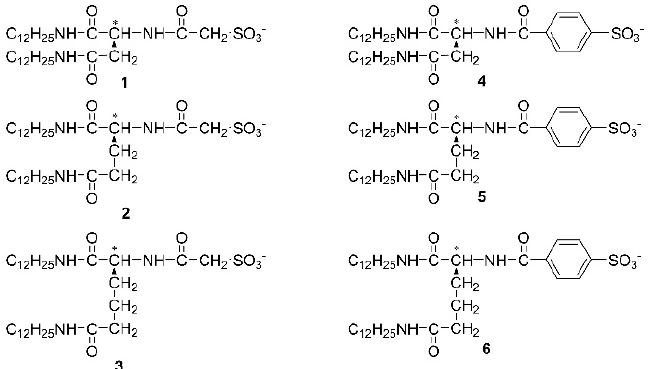
Figure 1. Chemical structure of lipid amphiphiles 1 – 6 . 1 – 3 have two dodecyl tails, amino acid connector,